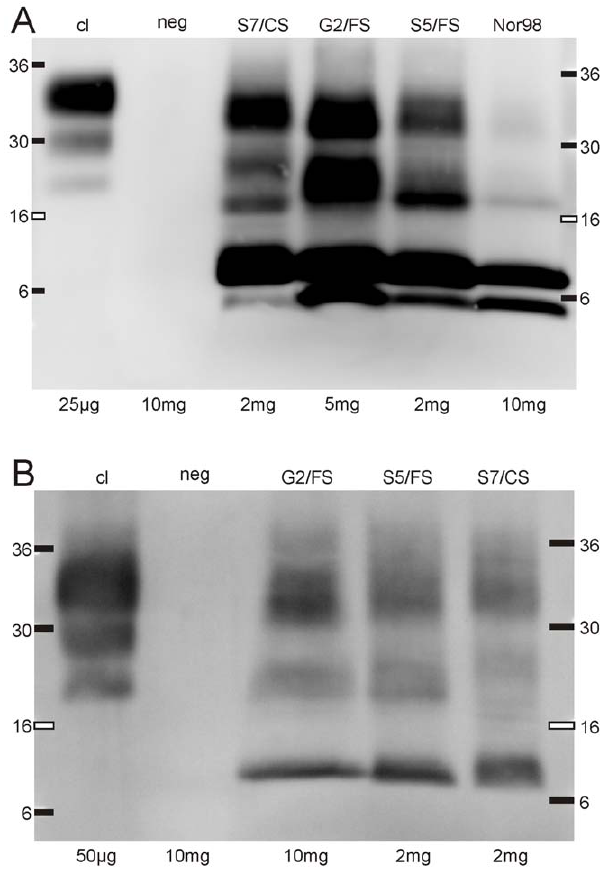
Figure 7. Molecular PrP res typing of atypical scrapie-affected sheep and goats. SDS-PAGE was performed using 4–20% gradient gels and blots were probed with mAb P4 (A) and Sha31 (B) . Samples of a classical scrapie-affected sheep (cl) and a TSE-negative sheep (neg) served as controls. Molecular mass standards and tissue equivalents are